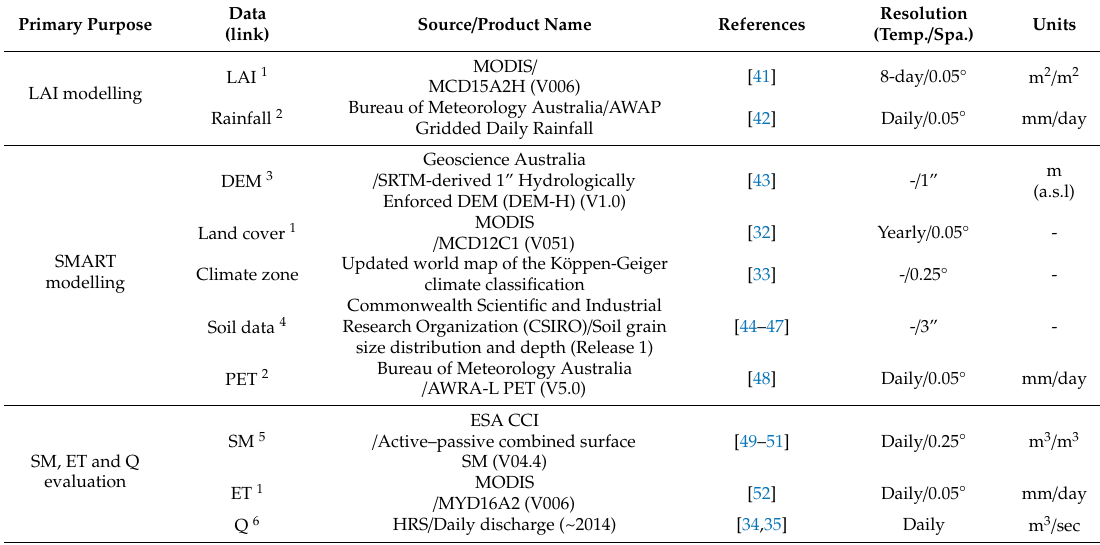
Table 2. Summary of Data Used in this Study with Data Links Presented below the